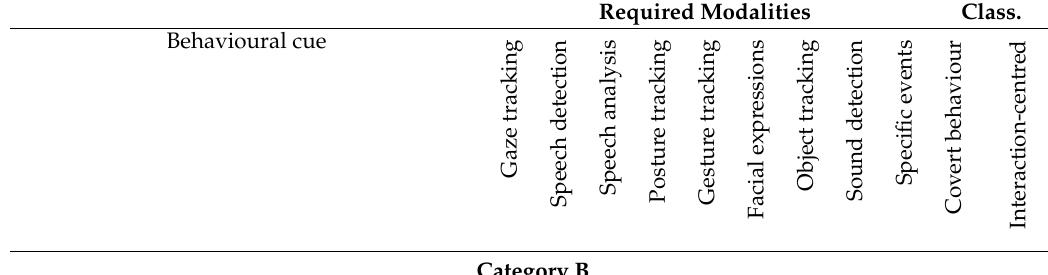
Table 2. Detailed breakdown of the behavioural cues for Category B that a therapist might use in ASD diagnosis based on DSM-5 criteria, and the corresponding required modalities.